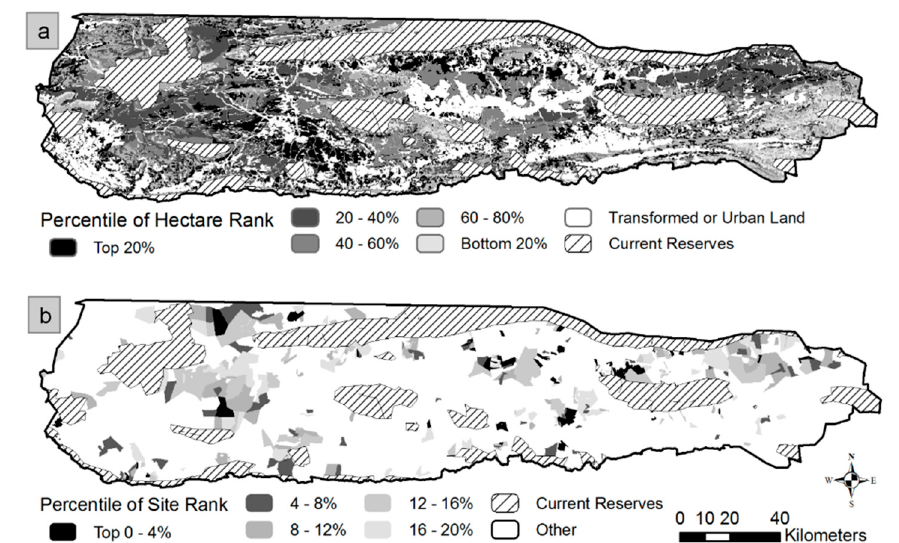
Figure 6. The most user-useful SDSS output was surprisingly the “Habitats Representation Value” (which includes succulent habitat score, as per Figure 2). This output is represented here as ( a ) the value per hectare, and ( b ) the average hectare value per site. The top 20% of the sites are mapped rather than the top 10% to get a comparable amount of area mapped as Figure 3. The disparity with Figure 3 regarding average site size is primarily because cost is not considered here.